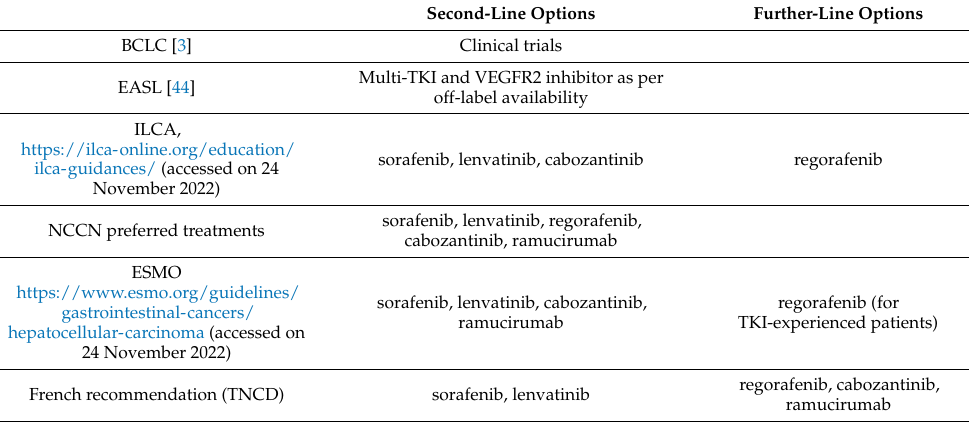
Table 3. Existing guidelines regarding subsequent treatment after atezolizumab-bevacizumab combi-